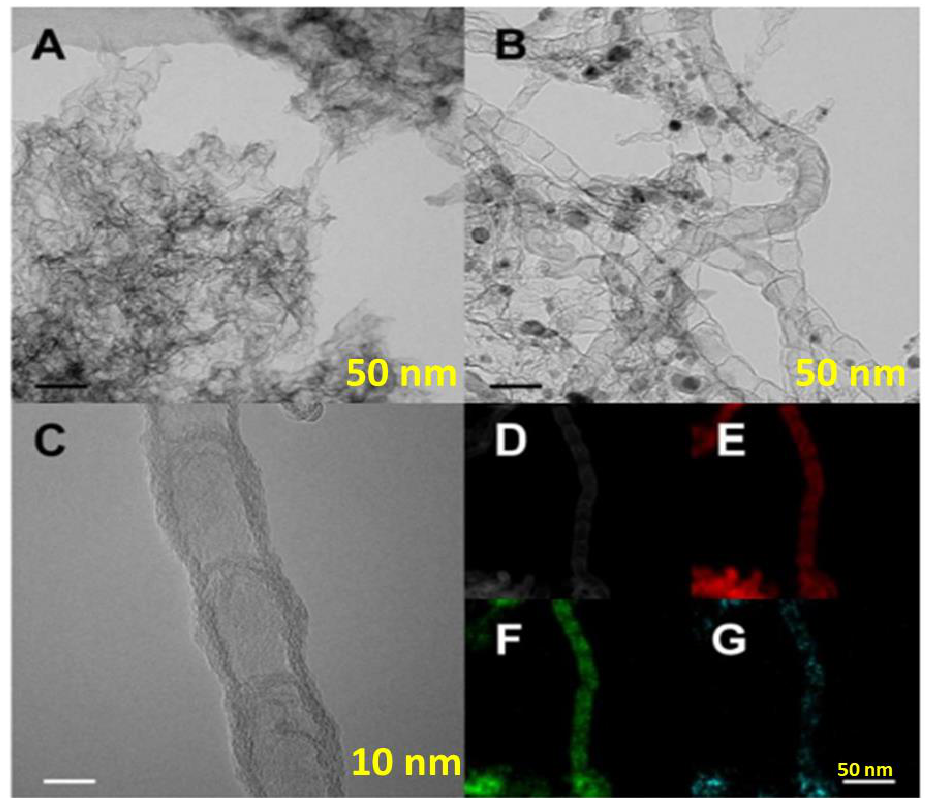
Figure 16. TEM images of ( A ) NCNS-T800, scale bar 50 nm, and ( B ) Co-NCNT-T800, scale bar 50 nm; ( C ) high-resolution TEM image of Co-NCNT-T800, scale bar 10 nm; ( D ) high-angle annular dark-field scanning transmission electron microscope (HAADF-STEM) image and element mapping of ( E ) carbon, ( F ) nitrogen, and ( G ) cobalt for Co-NCNT-T800, scale bar 50 nm. Adapted with permission from ref. [101].